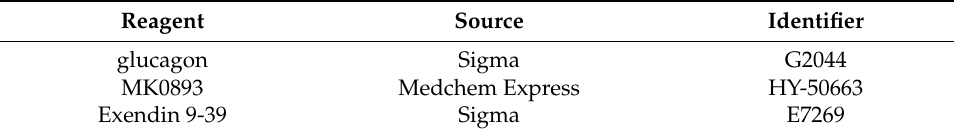
Table 1. The information of glucagon-related